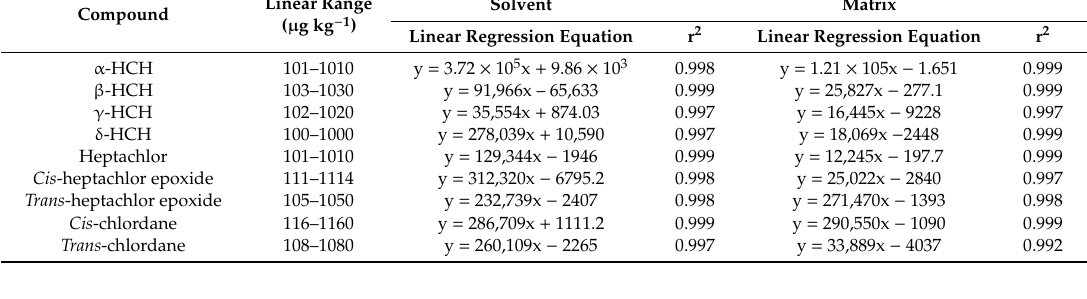
Figure 4. Analytical curves of α -HCH in ACN solvent and soil matrix. Figure 3. Selectivity chromatogram of the organochlorine compounds standards ( a ) 0.1 µg mL − 1 in ACN and ( b )